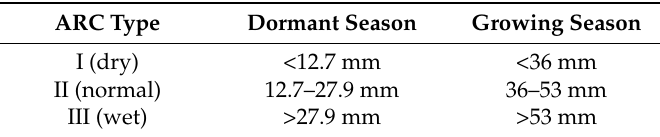
Table 6. ARC types based on P 5 .